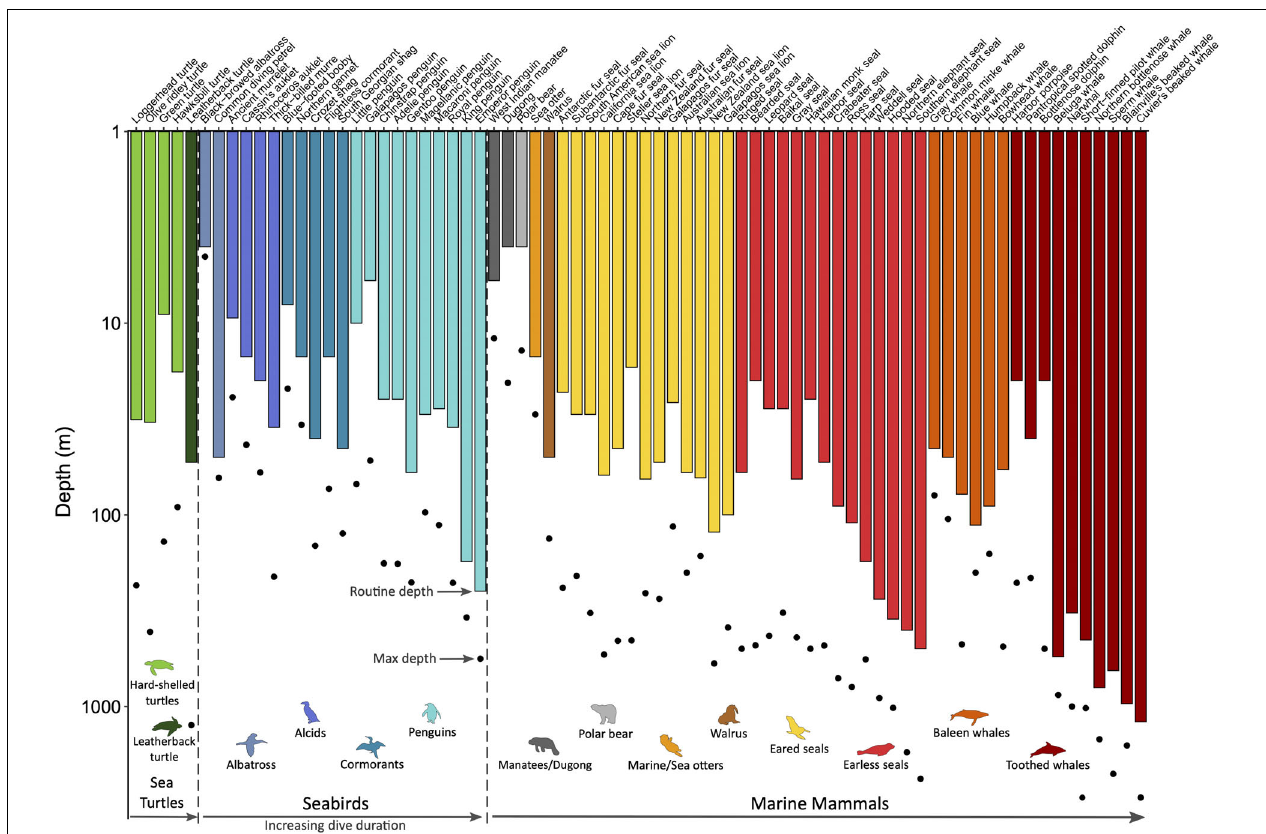
FIGURE 3 | Routine and maximum dive depths across marine air-breathers. Within the three taxonomic groups (sea turtles, seabirds, and marine mammals), species are grouped by order/family as indicated by the common names associated with the colored animal icons and then ordered by increasing routine dive duration. Species for which routine diving behavior data are available from time-depth recorders were included to demonstrate the physiological plasticity within a species (i.e., routine vs. maximum depth) and the range of diving abilities within each order/family and across taxonomic groups. Refer to Supplementary Table S3 for data